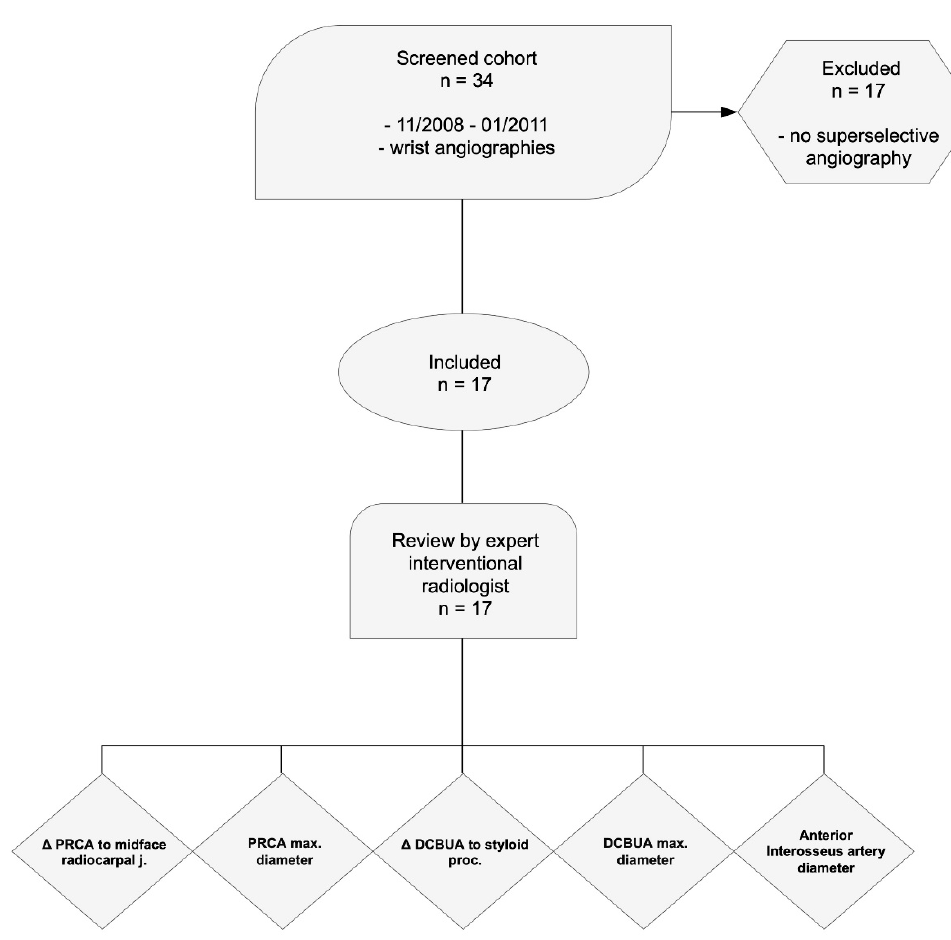
Figure 1. Study protocol according to the STROBE Initiative [24] showing patient screening, inclusion, exclusion, and analysis (STROBE = The Strengthening the Reporting of Observational Studies in Epidemiology Initiative; PRCA = palmar radiocarpal arch; DCBUA = dorsal carpal branch of the ulnar artery).